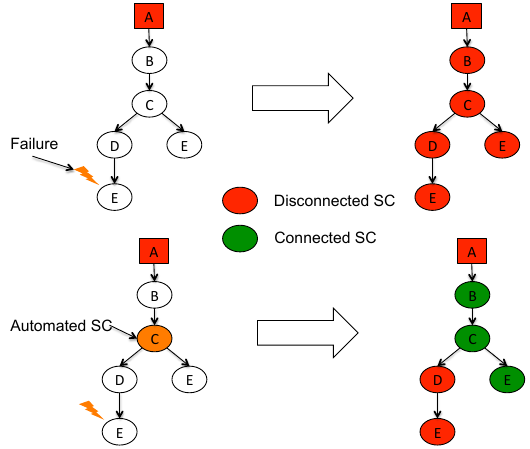
Figure A3. The simulation of protection